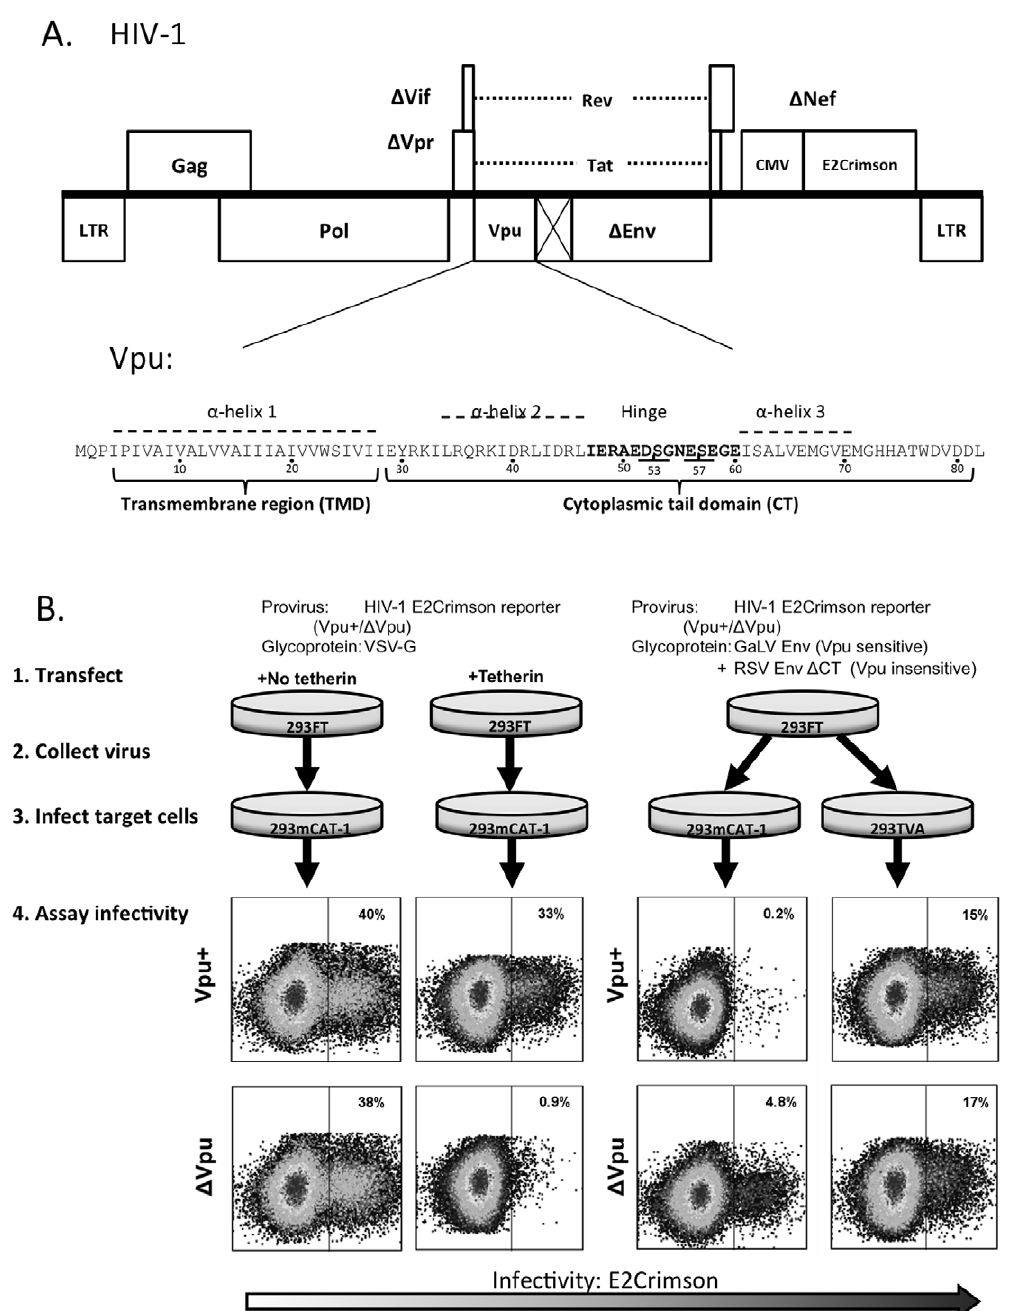
Figure 1. Schematics of HIV-1 proviral construct and experimental assay. (A) HIV-1 NL4-3 proviral construct with E2Crimson reporter showing enlargement of Vpu schematic outlining critical features in Vpu. Dotted outline predicted a -helices [22], bold script indicates the hinge region and underlined script highlights phosphorylated serines at positions 53,57. (B) For tetherin assays, 293FT cells were transfected with the following expression constructs: provirus and VSV-G with or without tetherin. For GaLV Env assays, cells received provirus, RSV Env D CT, and MLV/ GaLV Env (GaLV Env) [1,2]. Transduced cells were analyzed by flow cytometry two days later. Flow plots illustrate typical data output for positive controls (X-axis: E2Crimson expression, Y-axis: